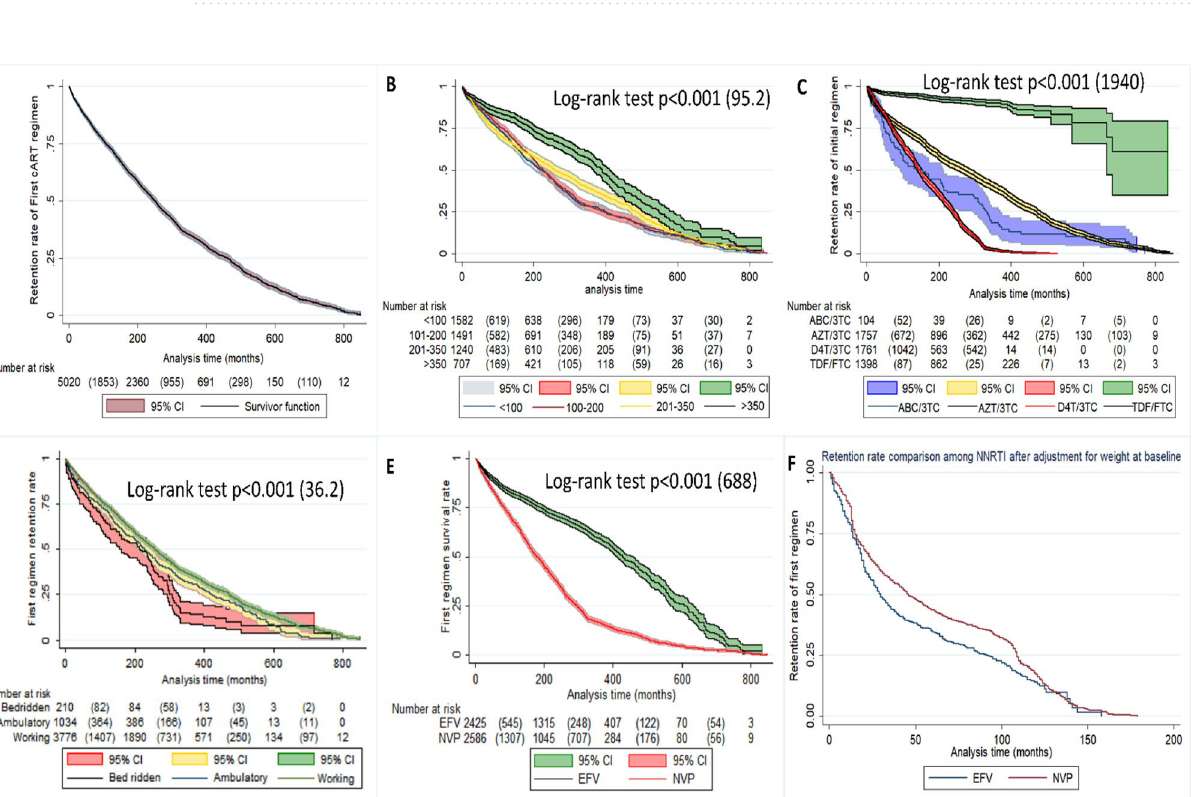
Table 3. Modifications (switches and substitutions) rate across the order of cART regimens used among PLWHA in hospitals of Asmara, 2005–2021.